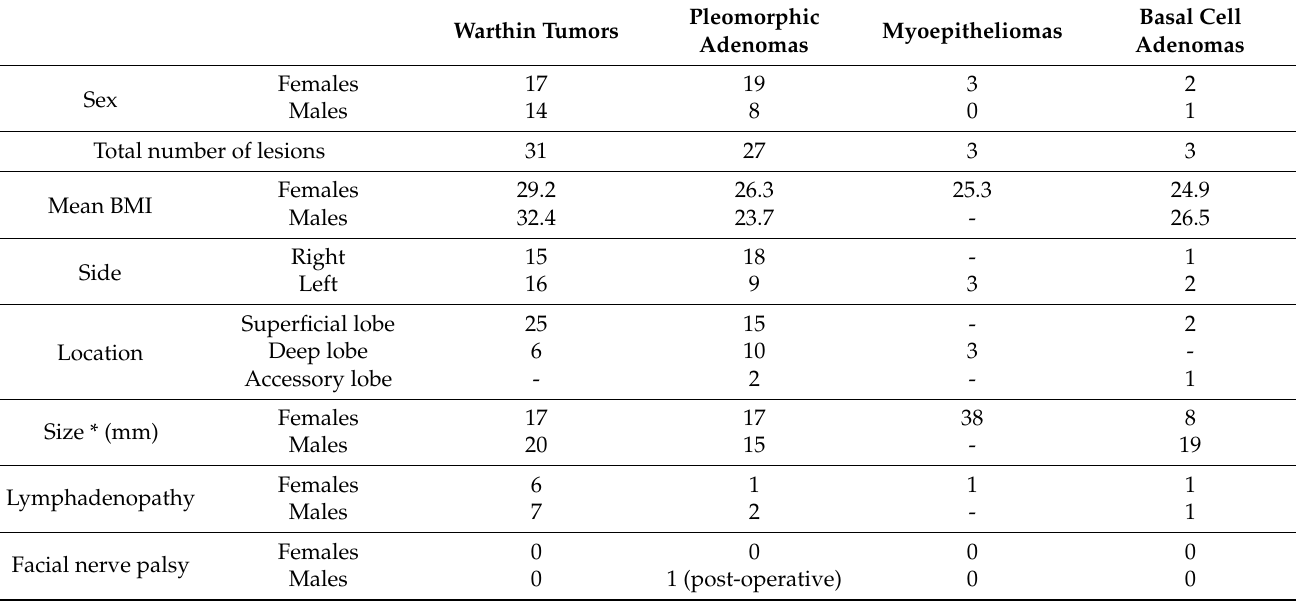
Table 1. Final study cohort demographic